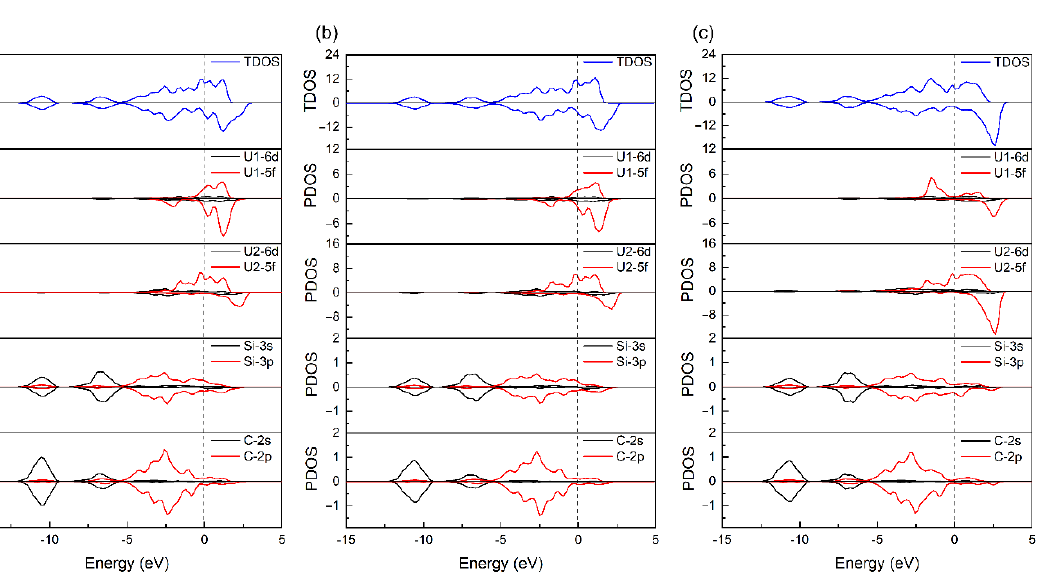
Figure 6. The total density of state (TDOS) and partial density of state (PDOS) of U 3 Si 2 C 2 under different pressures. ( a ) 0GPa; ( b ) 8GPa; and ( c ) 12GPa. The dash line represents Fermi energy.